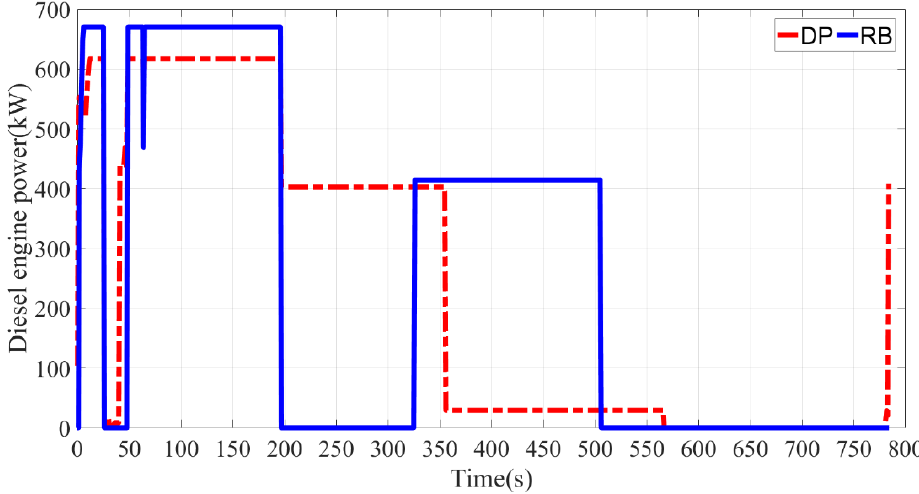
Figure 14. Comparison of diesel engine power between DP strategy and RB strategy.